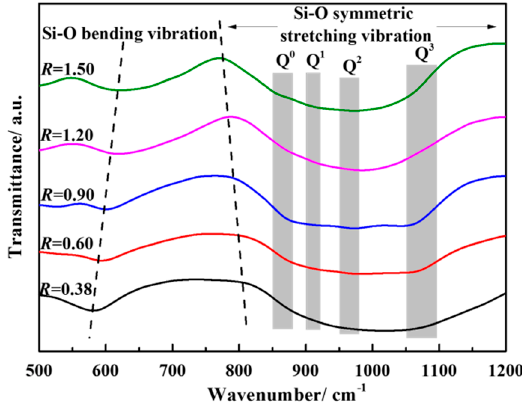
Figure 13. FT-IR spectra of the water quenching slag sample.